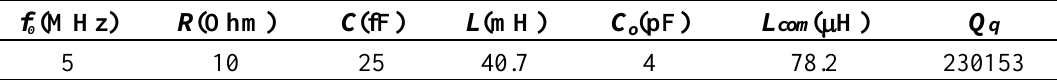
Table 1. Quartz data for resonant frequency 5 MHz